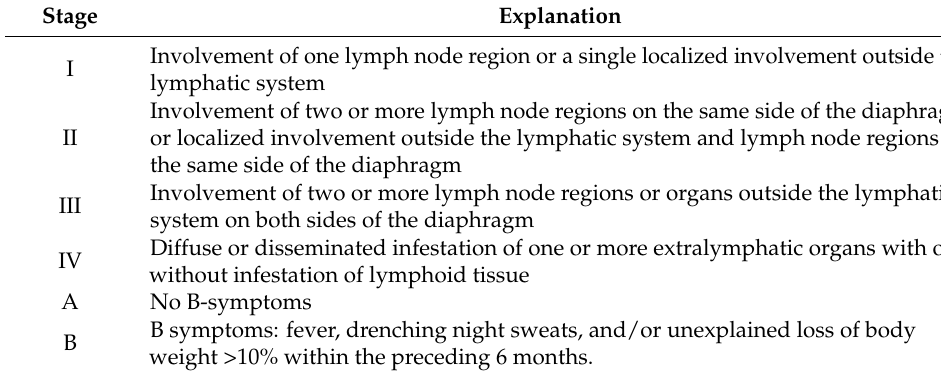
Table 1. Ann Arbor classification for Hodgkin’s lymphoma.